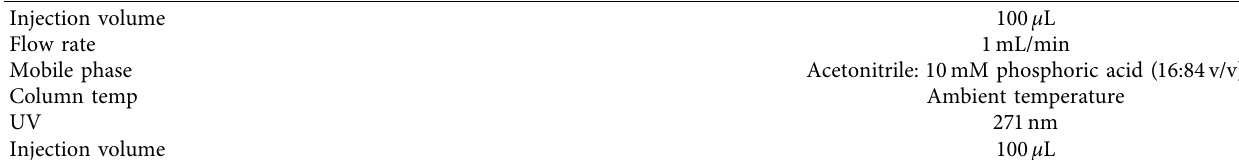
Table 2: Reagents, equipment, and chromatographic conditions for detection of the antibiotic residues.